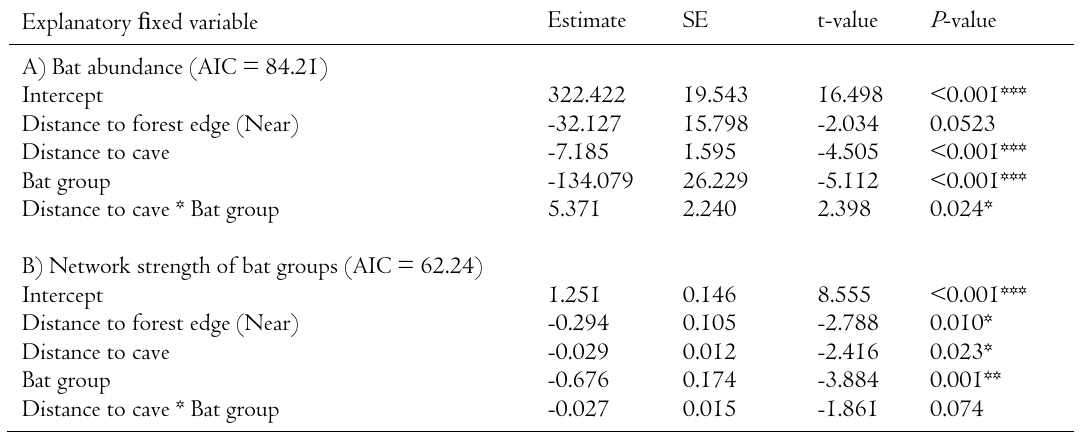
Results of generalized linear mixed models for (A) bat abundance and (B) network strength of bat. Fixed effects include distance to the forest edge, distance to cave, and bat group.